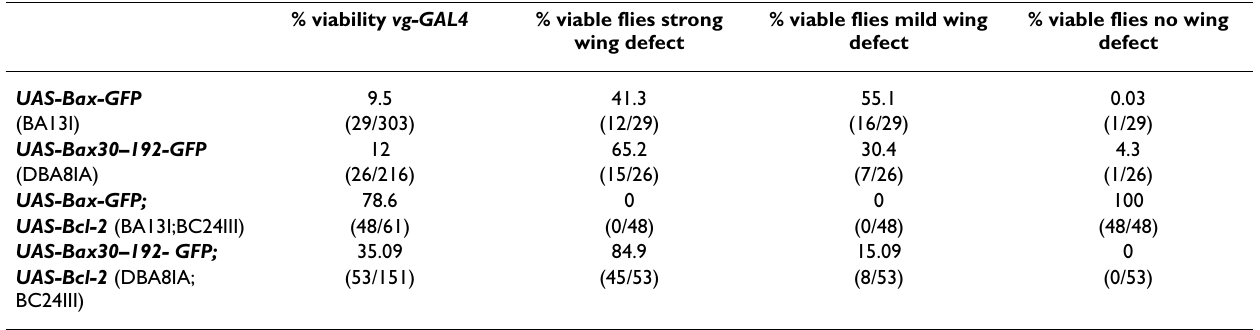
Table 2: Percent viability and extent of wing defect with vg-GAL 4 for additional UAS transgenic lines % viability